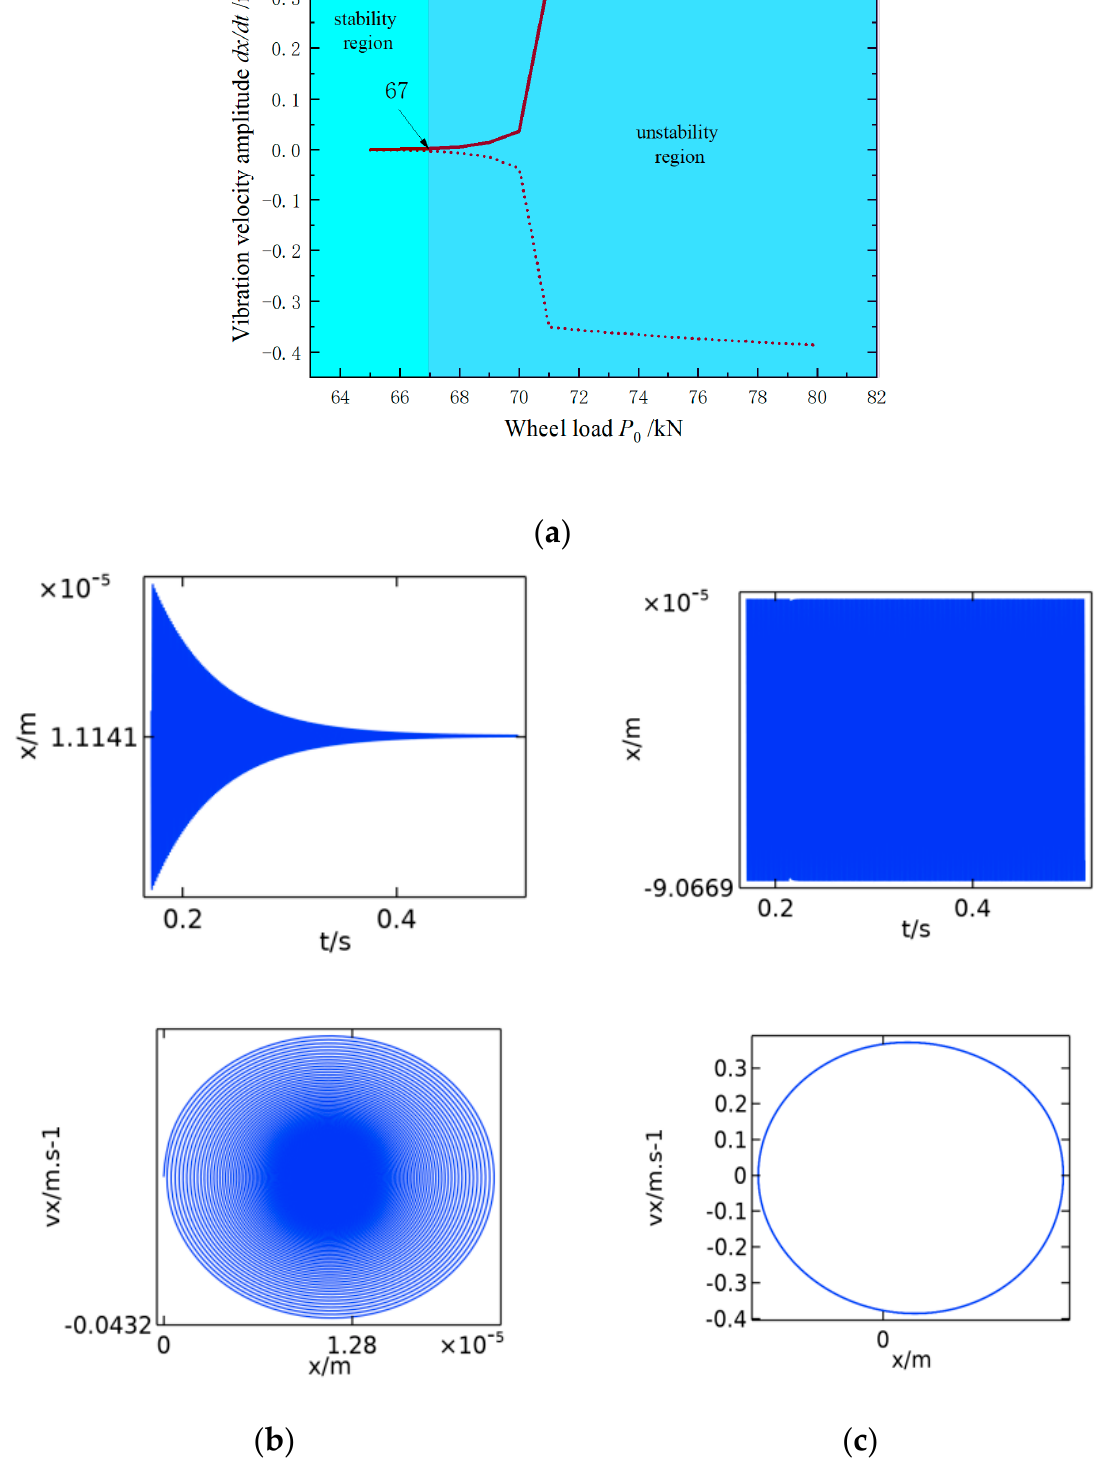
Figure 7. Influence of system with wheel load: ( a ) bifurcation diagram of the system; ( b ) time domain diagram and phase diagram at P 0 = 67 kN; ( c ) time domain diagram and phase diagram at P 0 = 80 kN.